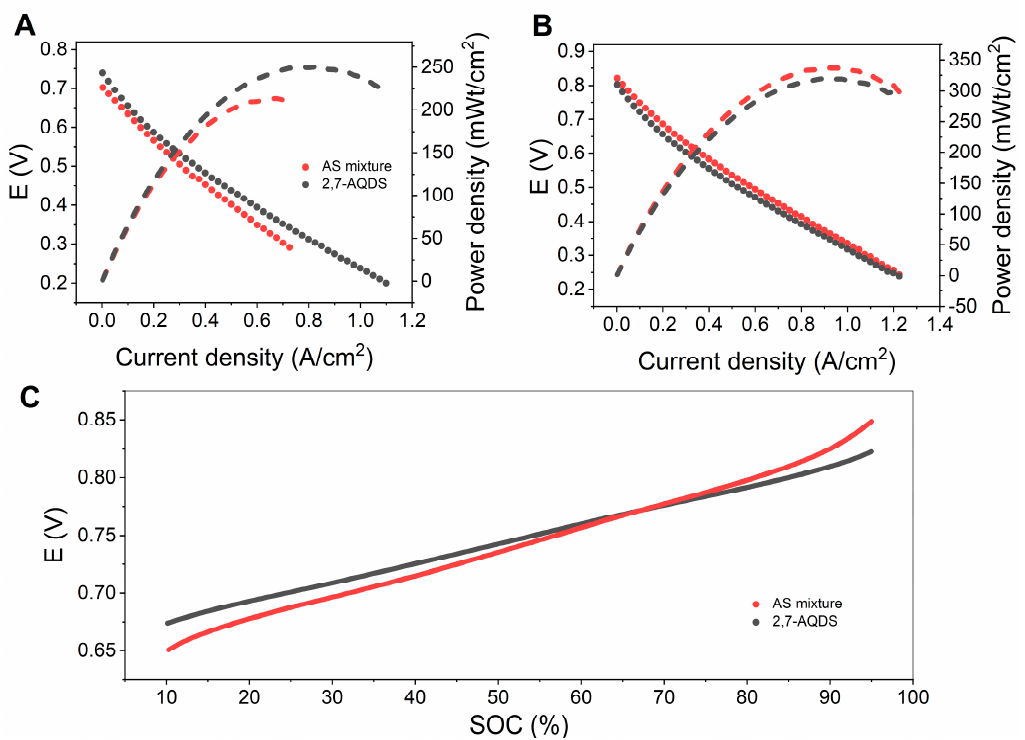
Figure 6. Polarization curves (dots) and corresponding power densities (dash) for ABRFB using as a negolyte ASM or 2,7-AQDS (0.4 M in 2.2 M H 2 SO 4 ). Membrane—Nafion 211, Flow field—flow through, SOC—50% ( A ) and 90% ( B ) Flow rate—100 mL min − 1 ( C ) Corresponding dependence of OCV vs. SOC.